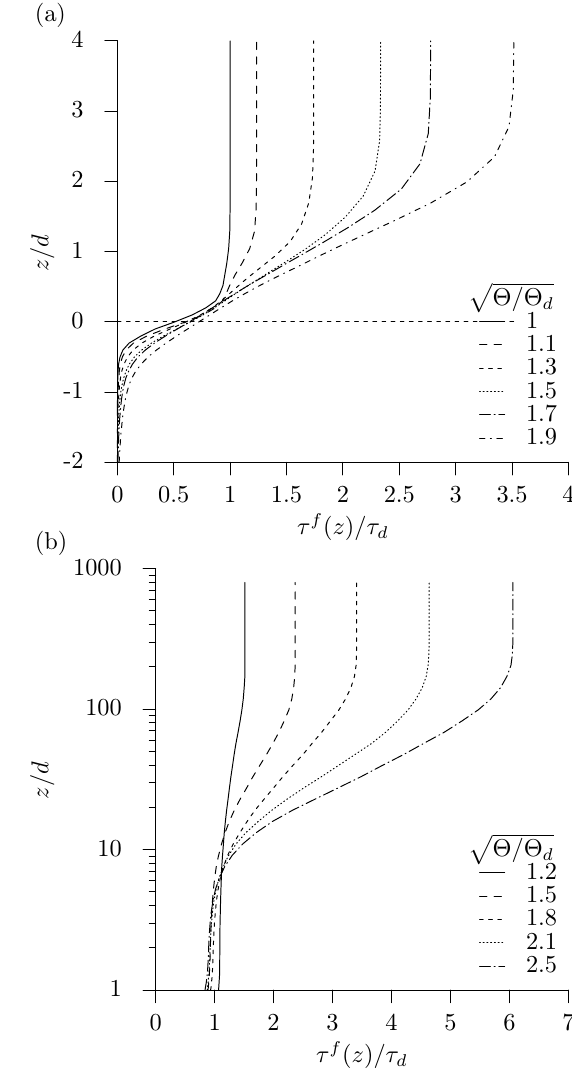
Fig. 3. Vertical profiles of the fluid borne shear stress τ f for differ- ent values of the shear velocity ratio (a) and air (b)